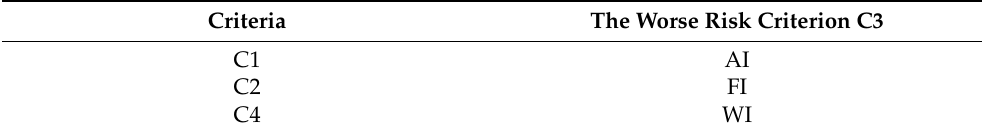
Table 3. The linguistic terms for fuzzy preferences of all other risk criteria over the worst risk criterion.